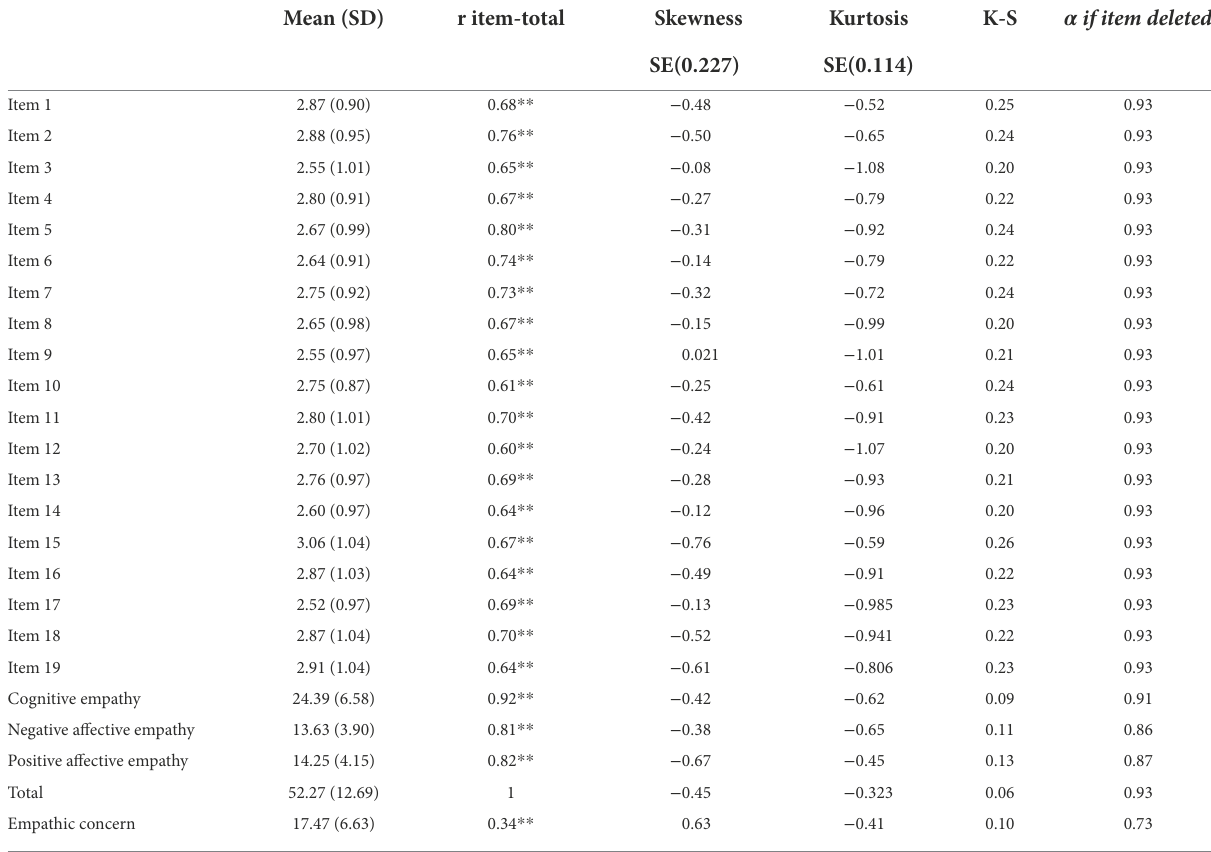
TABLE 2 Descriptive statistics, normality indices, and item analysis of Empathy Scale for Teachers (EST) (n = 462).